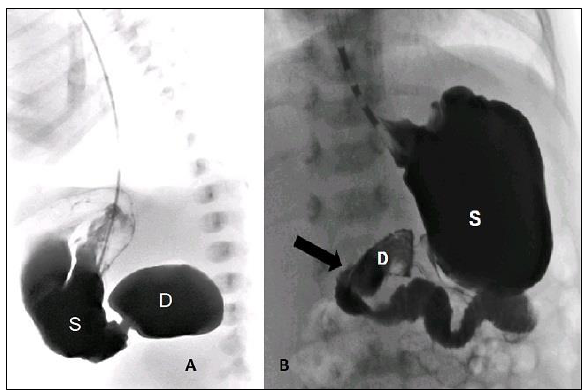
Figure 1: A) Contrast study showing duodenal atresia. B) Postoperative contrast study showing intact stomach and duodenal